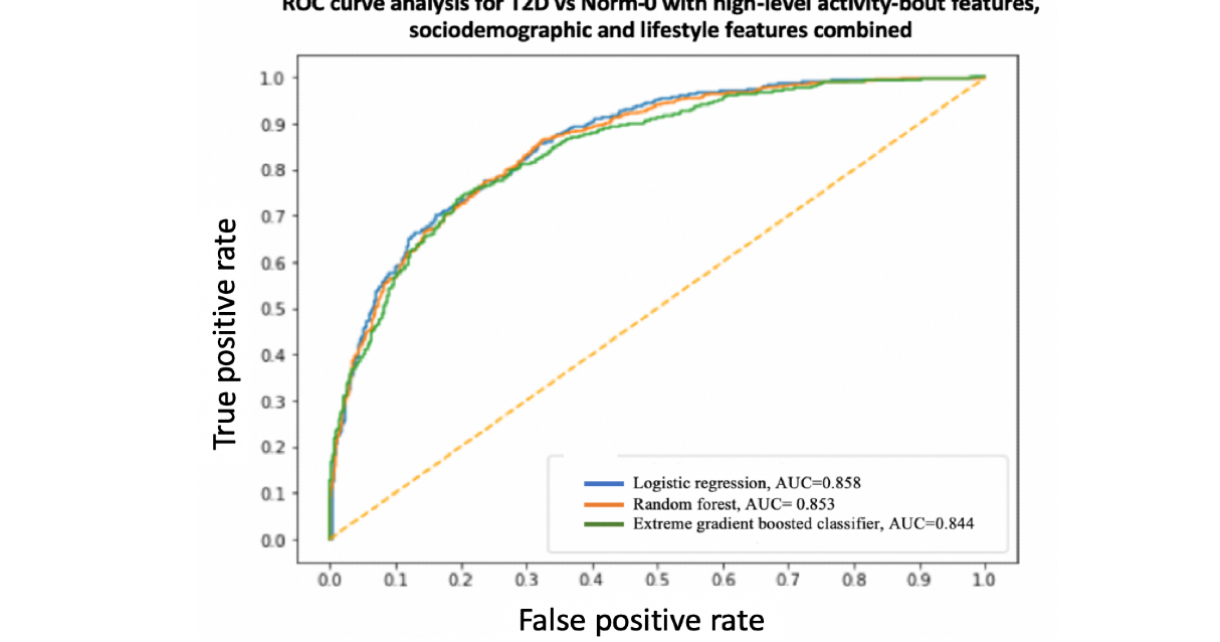
Figure 7. Receiver operating characteristic curve and area under the receiver operating characteristic curve for type 2 diabetes vs Norm-0: High-level activity bout features & sociodemographic and lifestyle features combined. AUC: area under the receiver operating characteristic curve; ROC: receiver operating characteristic curve; T2D: type 2 diabetes.